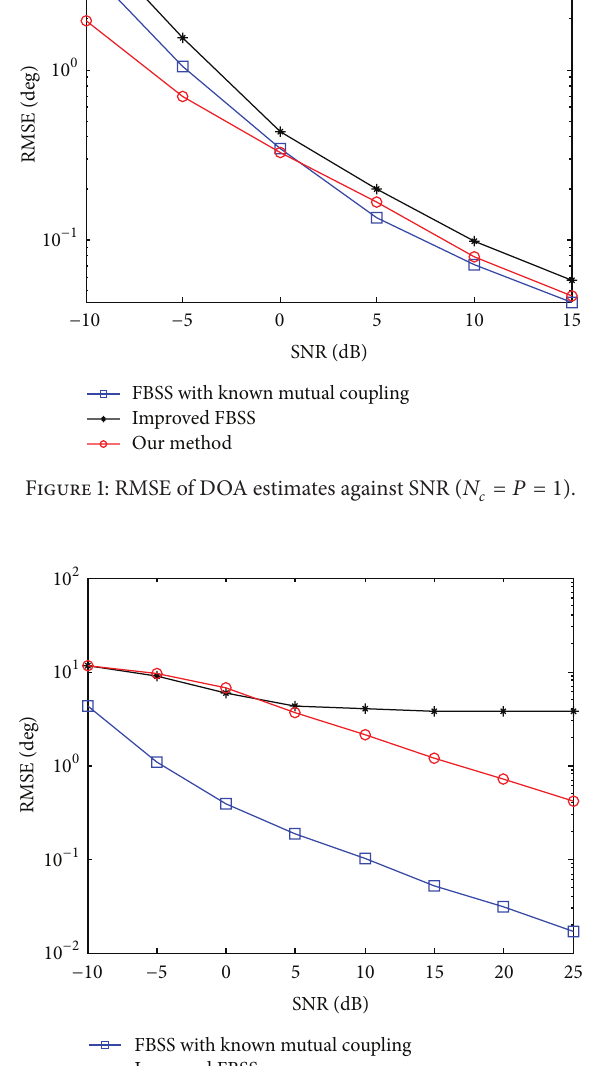
Figure 4: The RMSE of DOA estimation against SNR ( 𝑁 𝑐 = 1 , 𝑃 = 5 , 𝐾 = 10